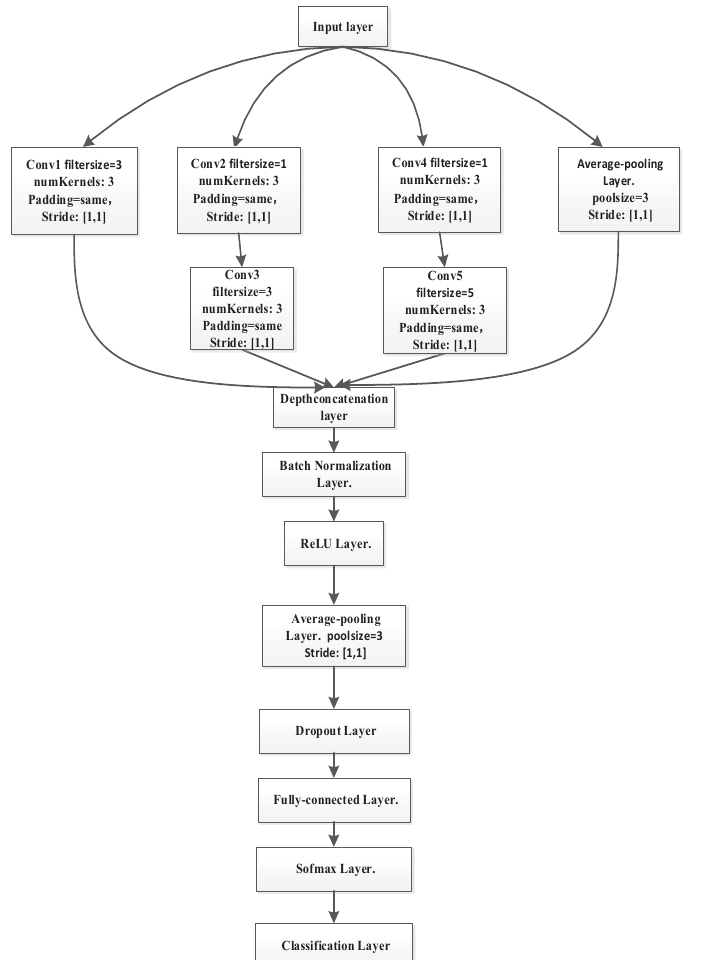
Figure 3. Structure and parameter settings of the convolutional neural network